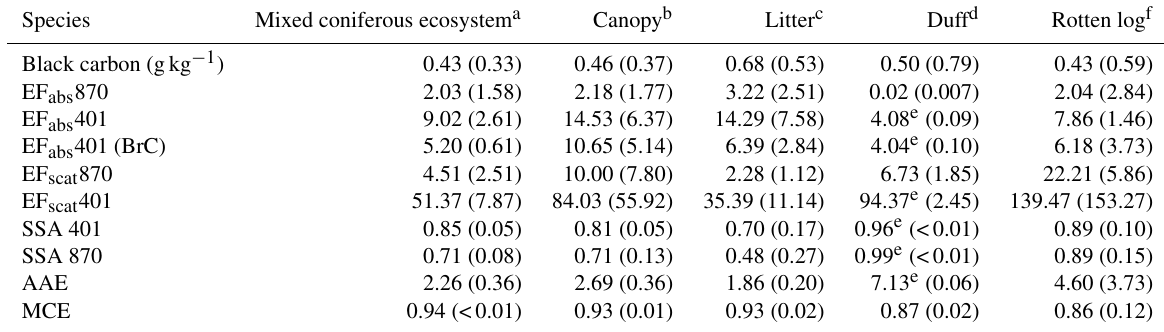
Table 5. Optical properties and emission factors (m 2 kg − 1 ) for mixed coniferous ecosystems and ecosystem components. Species Mixed coniferous ecosystem a Black carbon (gkg − 1